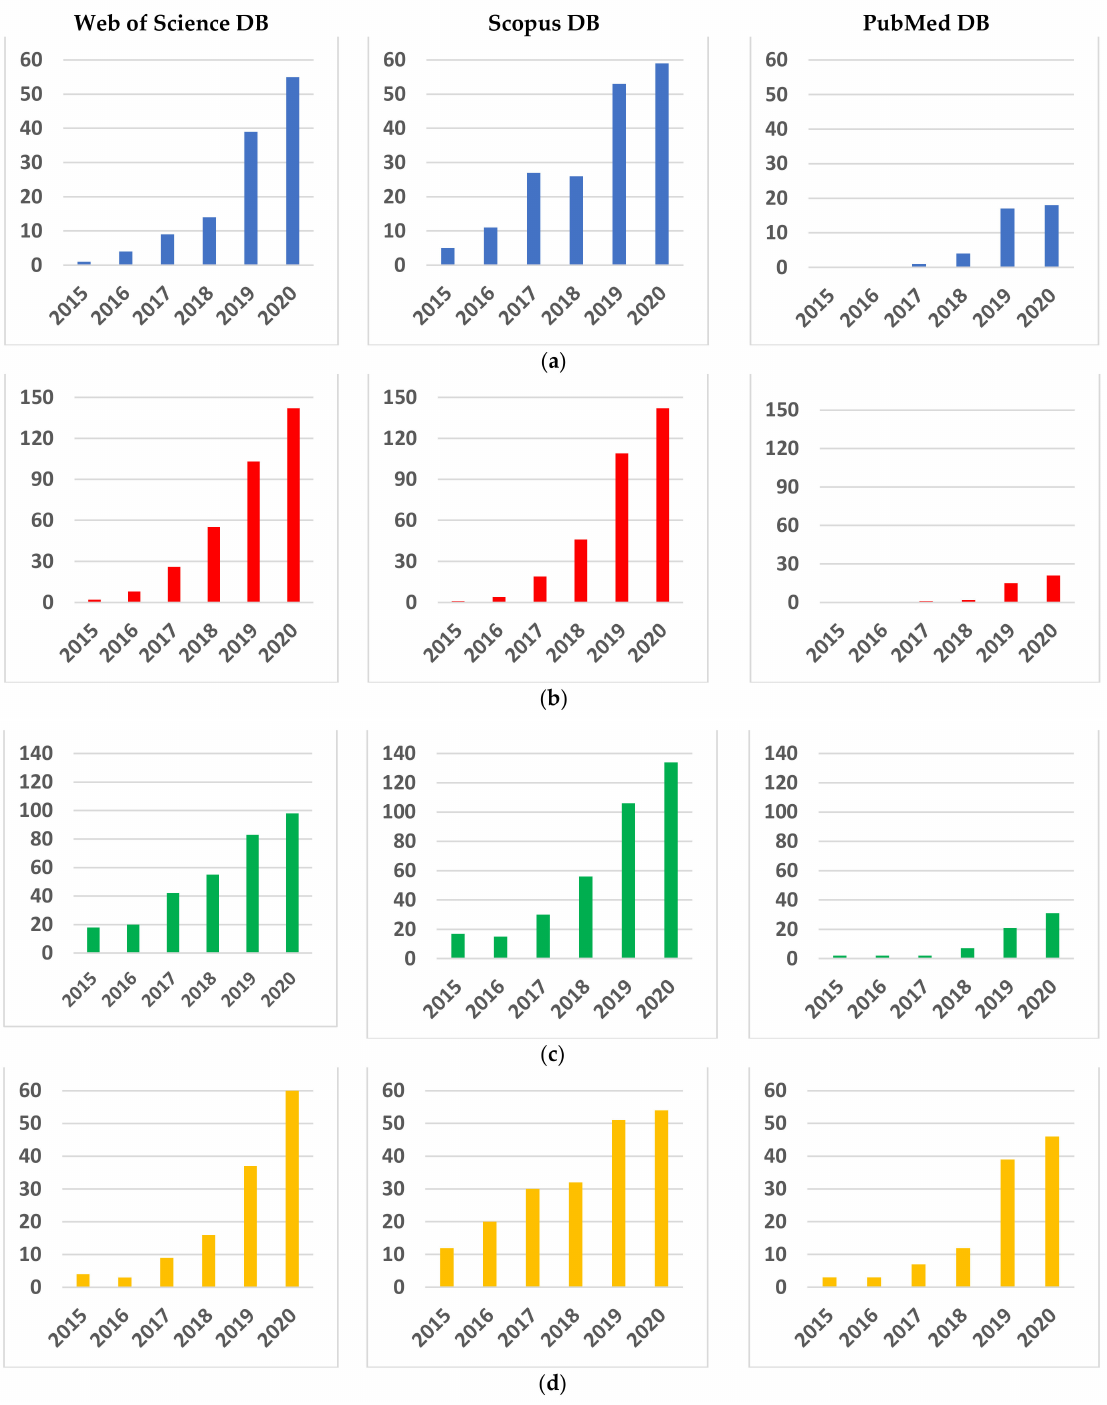
Figure 3. Searches for important terms in the Web of Science, Scopus, and PubMed DBs between 2015 and 2021 with the AND connector: ( a ) CNN AND Me, ( b ) DL AND Me, ( c ) ML AND Me, and ( d ) AI AND